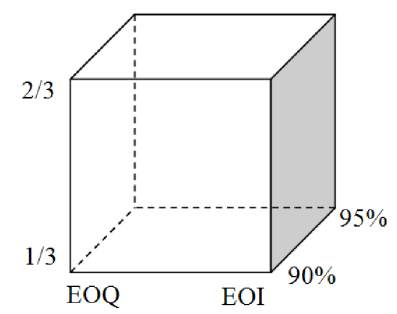
Figure 4. DoE: Factorial sub-plan TIE